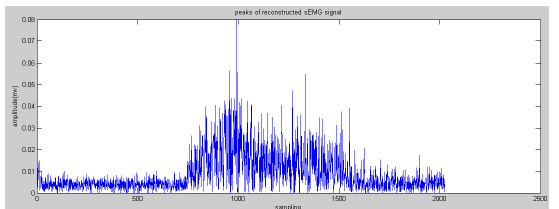
Figure 9. Peaks of the reconstructed sEMG in node 4.0.